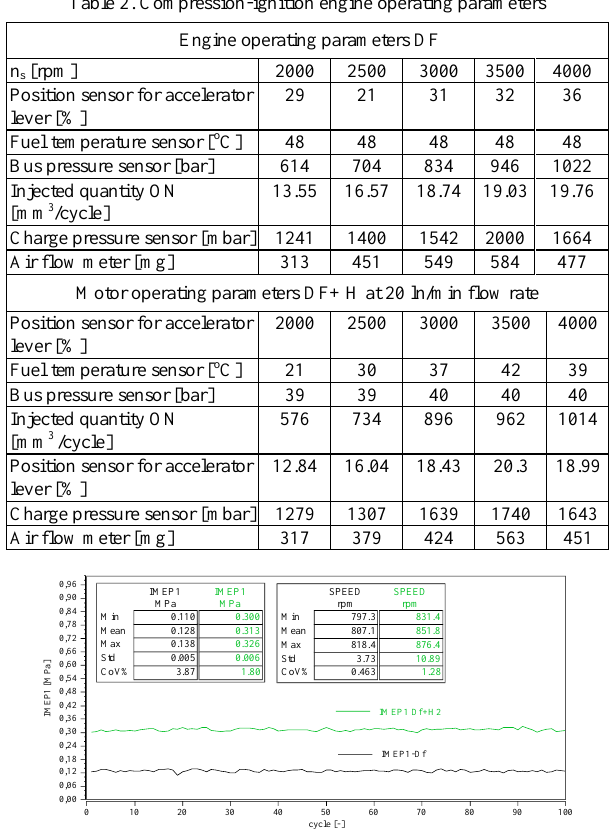
Table 2. Compression-ignition engine operating parameters